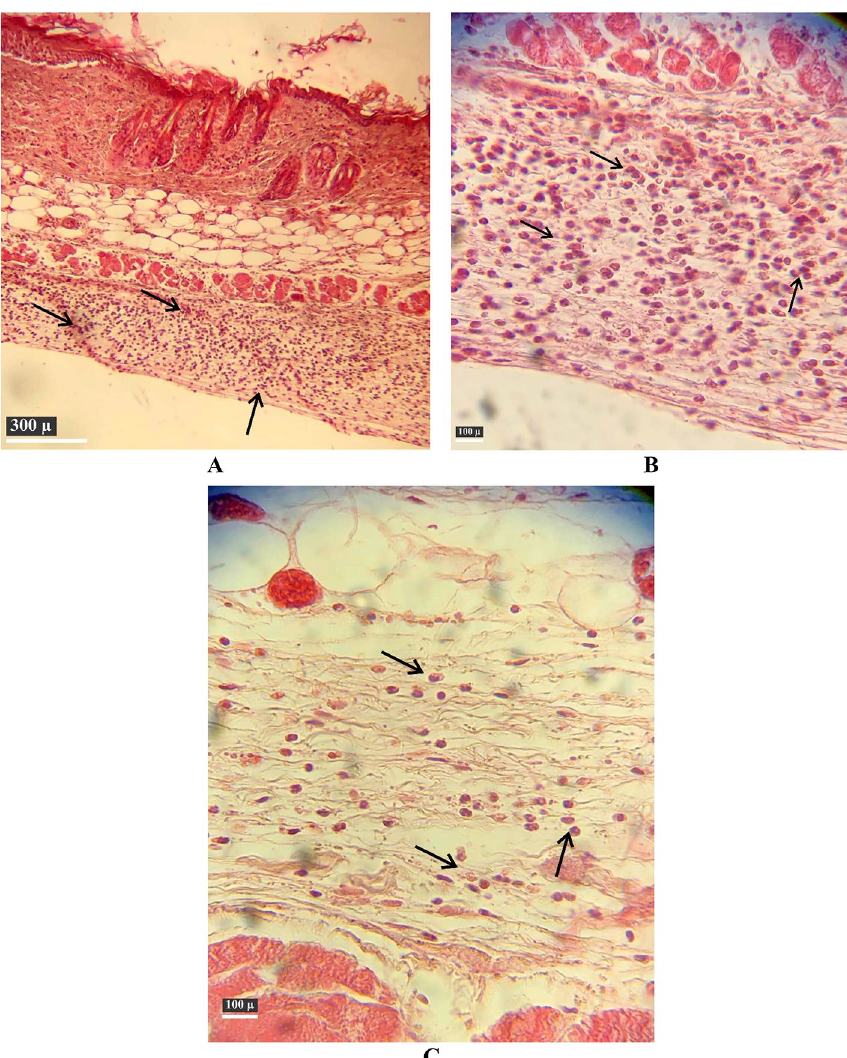
Figure 5. Histopathology of hypodermis. Histopathology analysis showed mild inflammation in the hypodermis of (PA-OMVs-DT + adj) immunized burned mice group. The difference in the histomorphology of burned skin is evident in the H&E-stained sections. In the control group, severe inflammatory cell infiltration is evident in the hypodermis ( A ) (100X), ( B ) (400X). ( C ) The skin of the (PA-OMVs-DT + adj) vaccinated mice revealed eightfold less inflammatory cell infiltration and tissue damage following infection as compared to the control group